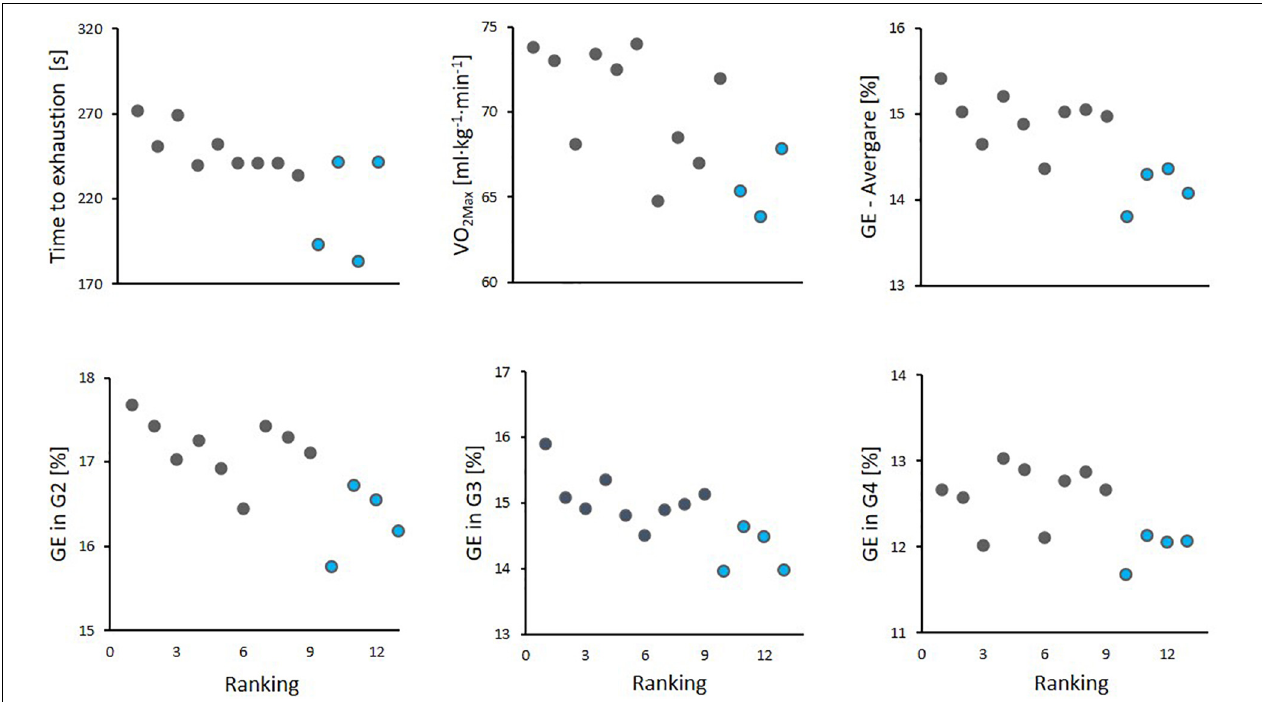
FIGURE 6 | Scatter plots for athlete ranking in the simulated mass-start with the following performance-determining variables: time to exhaustion in the maximal performance test, maximal oxygen uptake (VO 2 Max ) and gross efficiency (GE) (average for all sub-techniques (average), and for G2, G3 and G4 sub-techniques) for all 13 skiers. The 9 skiers completing the entire protocol without breaks are shown with black color, while the 4 skiers who needed breaks are shown in blue color.